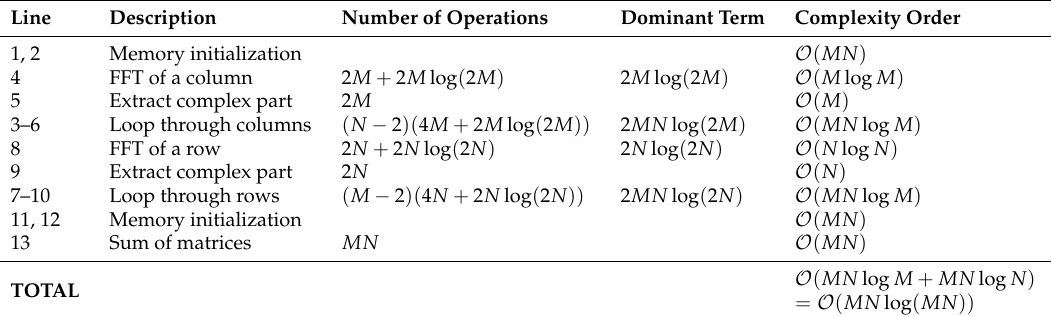
Table 1. Computational complexity analysis for Algorithm 2 (FFT padded with zeros). Complexity simplification rules applied are: (a) O ( kf ( n )) = O ( f ( n )) , (b) O ( f ( n ) + g ( n )) = O ( max ( f ( n ) , g ( n ))) .